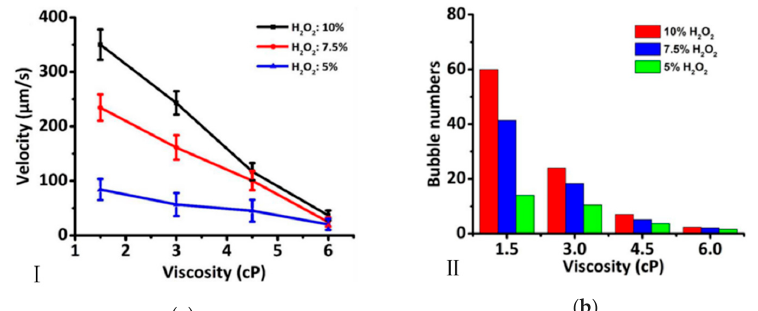
Figure 3. The influence of solution viscosity on the dynamic behavior of micromotors. ( a ) The velocity of micromotors decreases with the increase of solution viscosity; ( b ) the relationship between the frequency of bubble injection and the viscosity of fuel [62]. Reproduced with permission from